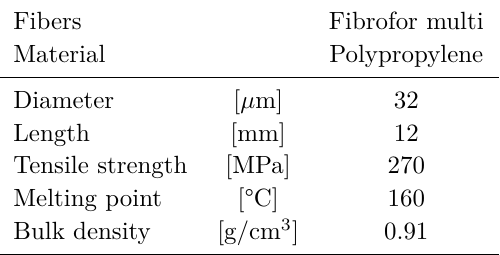
Table 1. Properties of selected fibers.